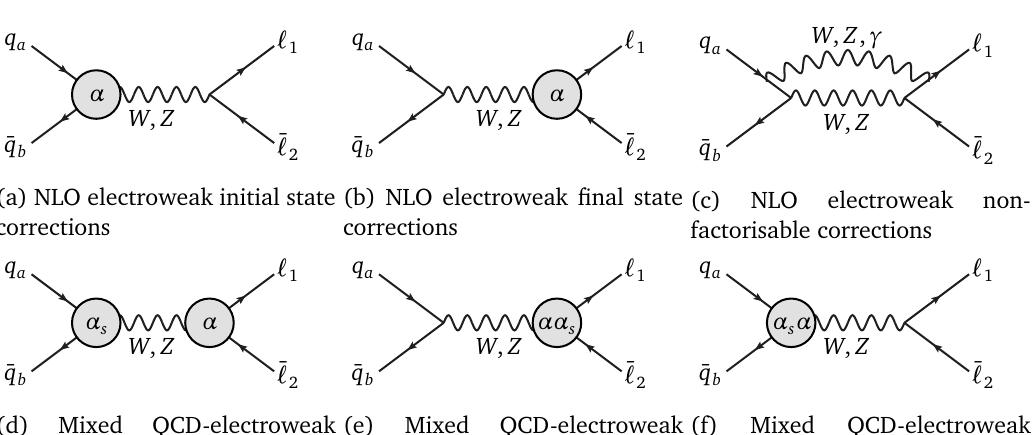
Figure 1: Schematic Feynman diagrams illustrating the different types of contribu- tions to the single vector boson production